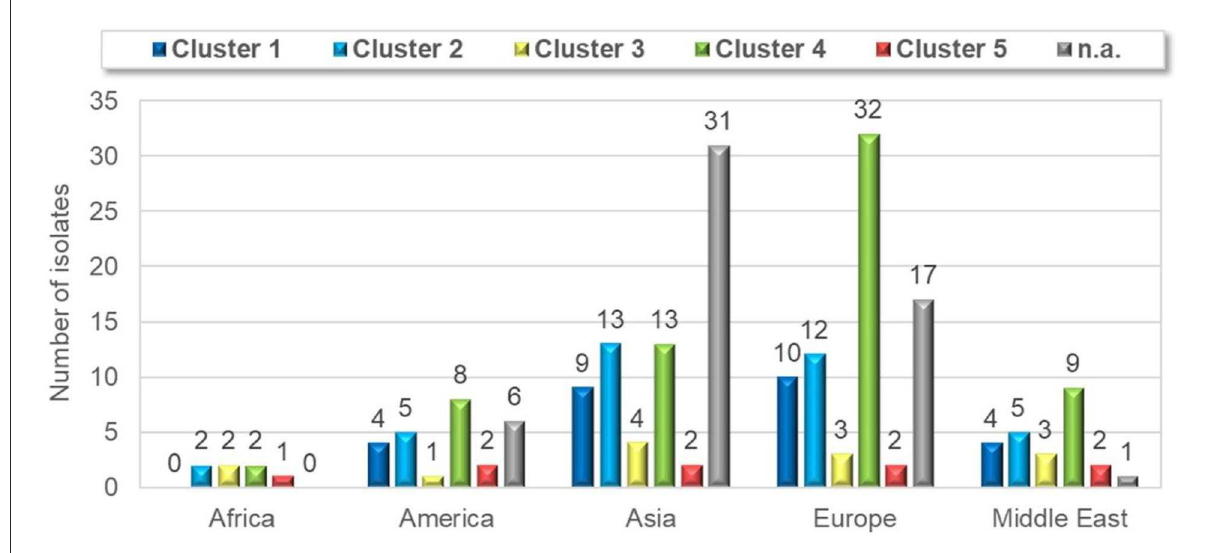
FIGURE4 Geographical distribution of different ARV clusters with the numbers of cases.